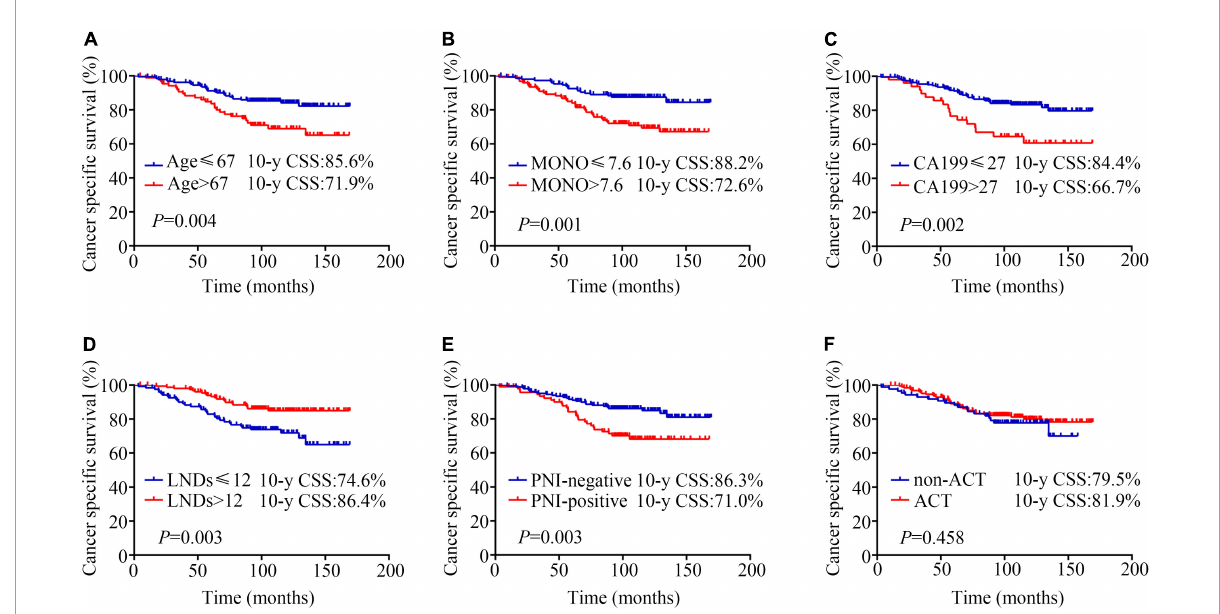
FIGURE1 Kaplan-Meier analysis of cancer specific survival according to (A) age ( ≤ 67 years vs. > 67 years, 10-y CSS: 85.6% vs. 71.9%, P = 0.004); (B) monocyte percentage (MONO%) ( ≤ 7.6% vs. > 7.6%, 10-year CSS: 88.2% vs. 72.6%, P = 0.001); (C) carbohydrate antigen 19-9 (CA199) ( ≤ 27 U/ml vs. > 27 U/ml, 10-year CSS: 84.4% vs. 66.7%, P = 0.002); (D) lymph node dissection numbers (LNDs) ( ≤ 12 vs. > 12, 10-year CSS: 74.6% vs. 86.4%, P = 0.003); (E) perineural invasion (PNI) (negative vs. positive, 10-year CSS: 86.3% vs. 71%, P = 0.003); (F) adjuvant chemotherapy